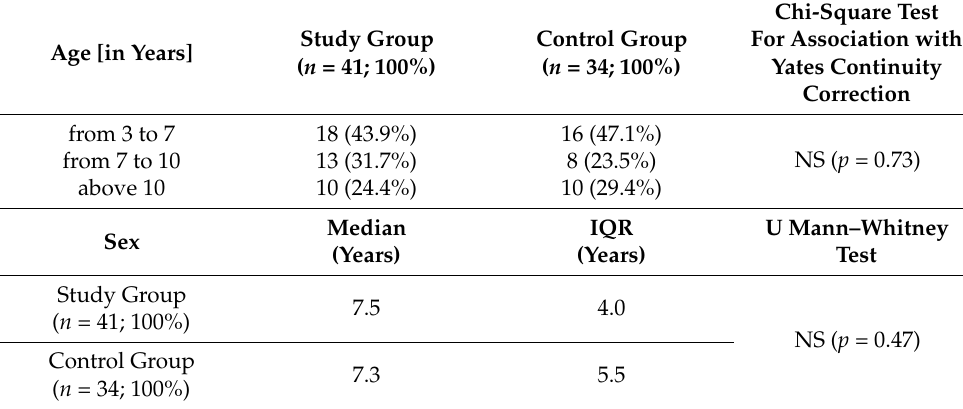
Table 2. Distribution of age in the Study Group and the Control